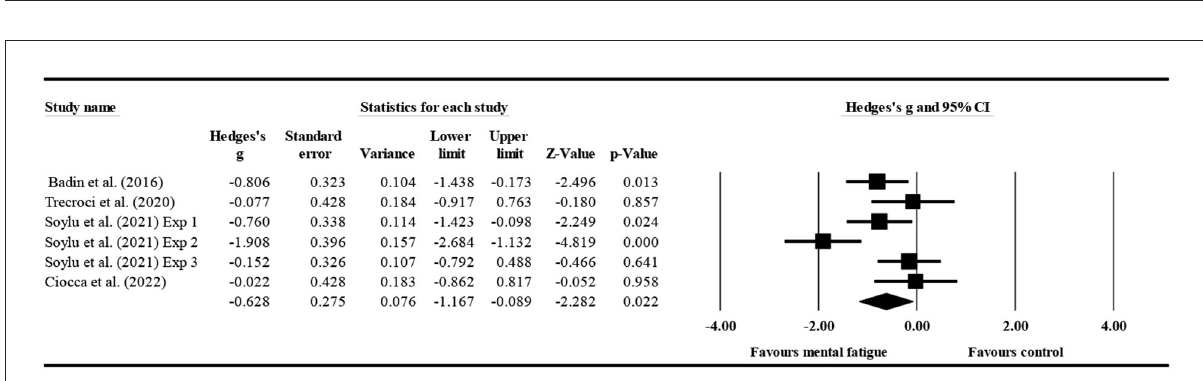
FIGURE8 Forest plot of changes in the percentage of successful tackles with the comparison of two conditions (mental fatigue and control condition). The results displayed are effect sizes with 95% CIs.